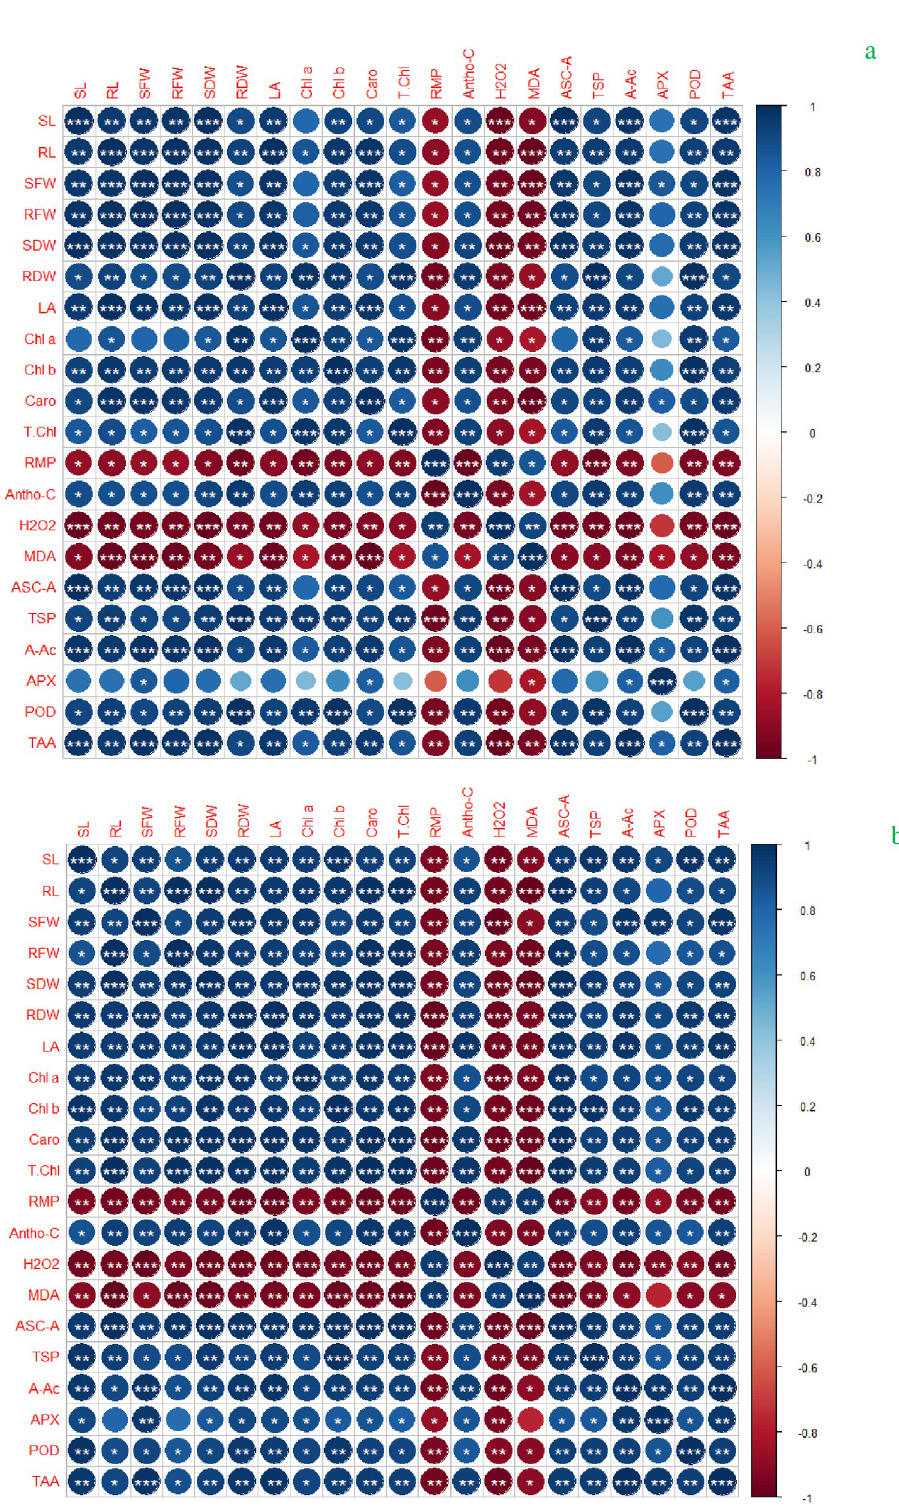
PLOS ONE | https://doi.org/10.1371/journal.pone.0269162 June 22,